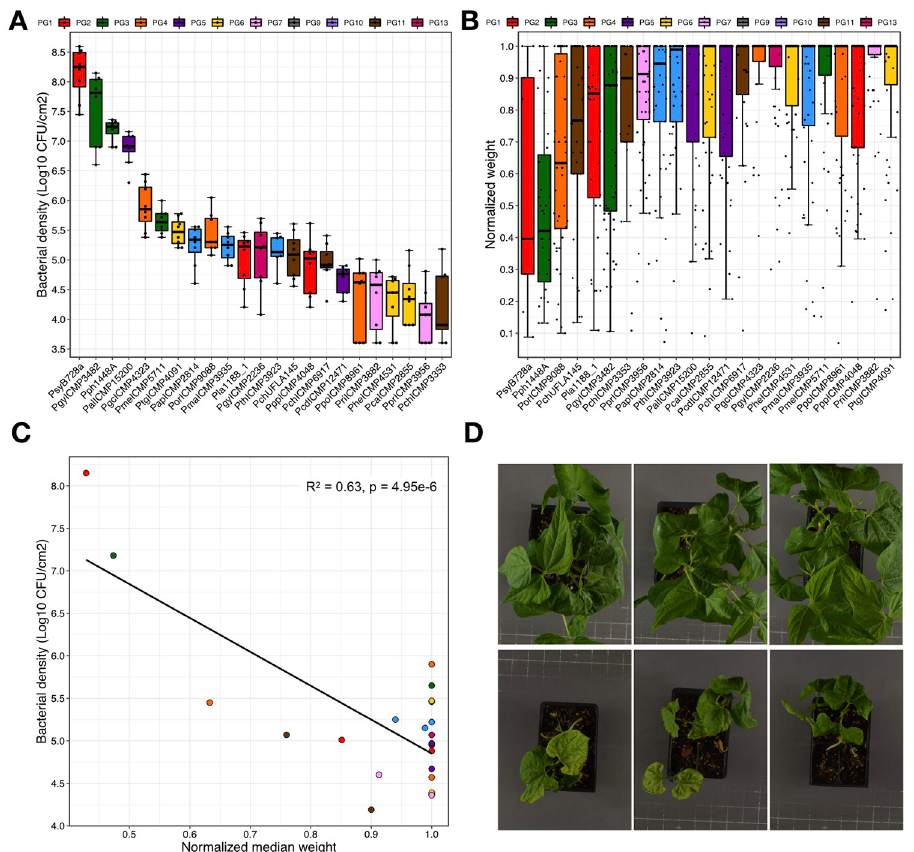
Fig 3. Correlation between bacterial load following pressure infiltration of mature bean leaves and plant weight following seed infection. (A) Bacterial density of 23 P . syringae isolates from 10 phylogroups in 14-day old, infected bean leaves (pressure infiltration 3 days post infection). (B) Normalized weight of 14-day old, infected bean plants (seed infected 14 days post infection) of 23 P . syringae isolates from 10 phylogroups. (C) Bacterial density in 14-day old, infected bean leaves (pressure infiltration 3 days post infection) as a function of normalized median weight of seed infected plants at 14 days old. There is a strong negative correlation between bacterial density and plant weight across 24 P . syringae isolates (linear regression; F = 36.95, df = 21, p = 4.95e-06, R 2 = 0.62). (D) Characteristic plant phenotypes of 14-day old plants following seedling infection. The photos at the top are for plants infected with MgSO 4 , while the at the bottom show plants infected with the bean pathogen PsyAB2012-008_22.